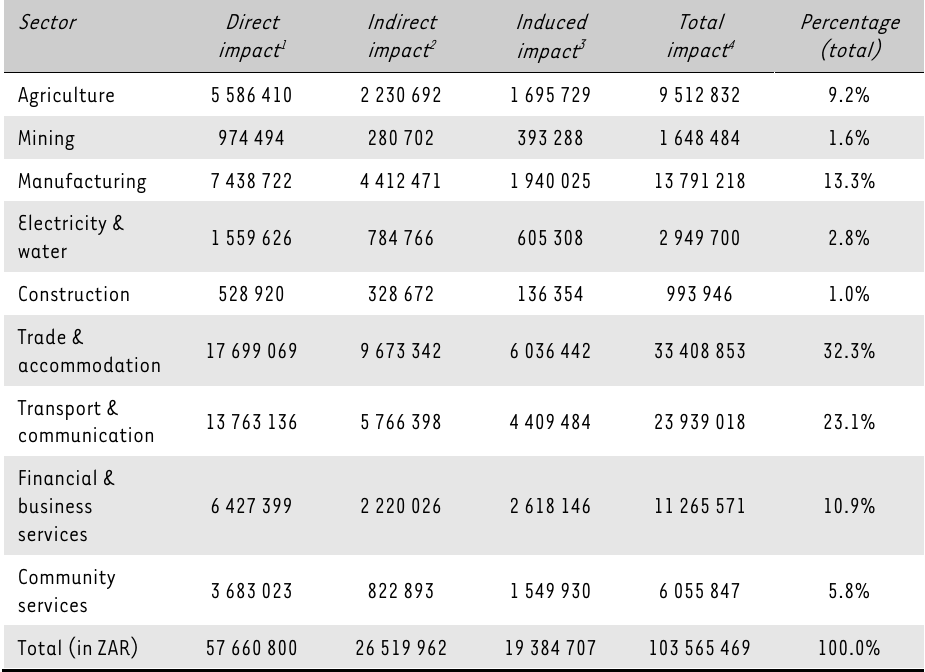
TABLE 2: Trophy hunters’ impact through production multipliers (ZAR, 2006 prices)